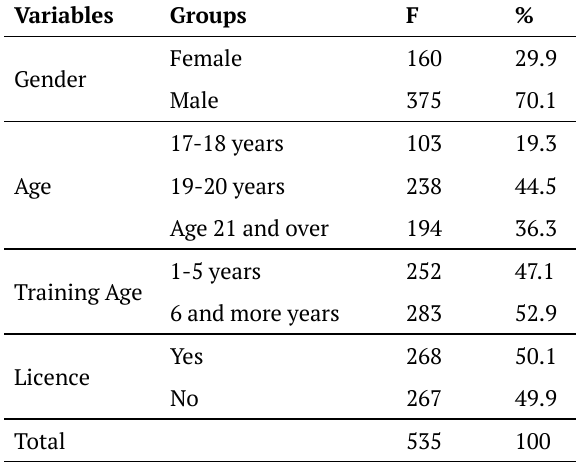
Table 1. Demographic information on